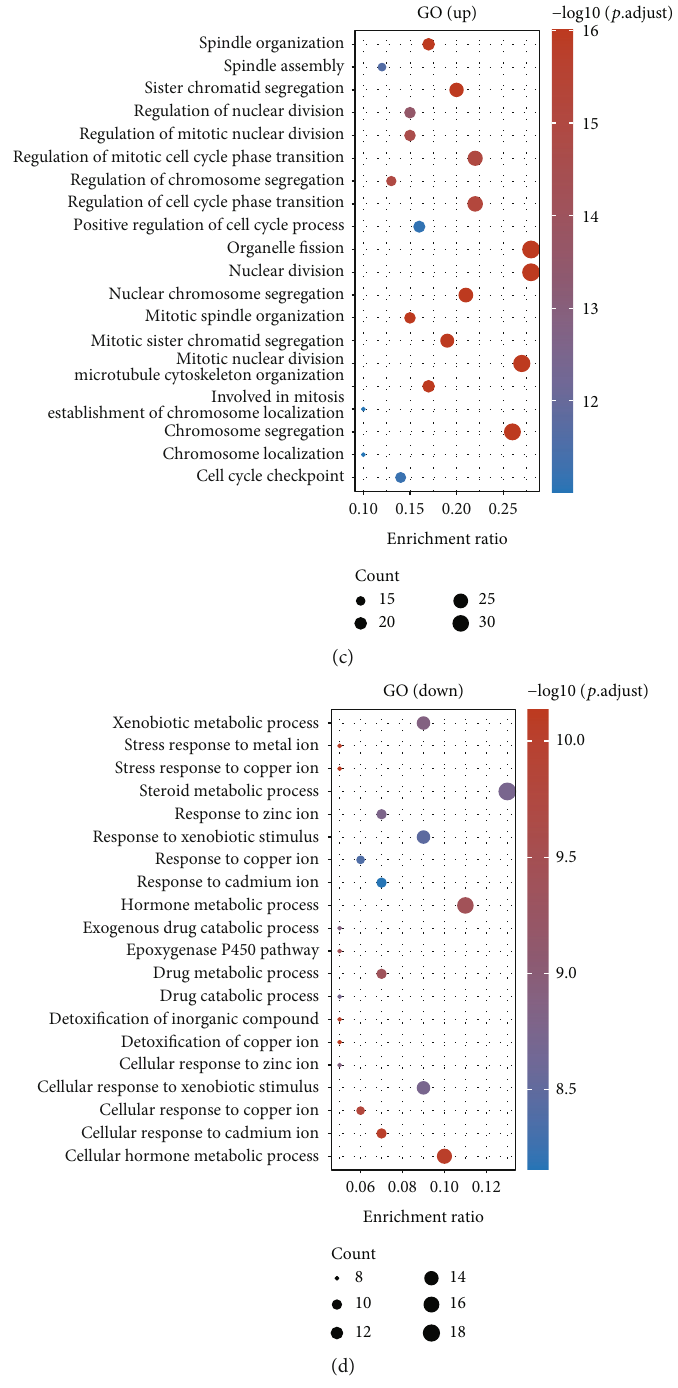
Figure 2: Functional investigation in accordance with the DEGs between normal and tumor groups in the TCGA group. (a) Barplot graph in terms of KEGG pathways. (b) Bubble graph in terms of GO enrichment using 125 increased genes. (c) Barplot graph in terms of KEGG pathways. (d) Bubble graph in terms of GO enrichment using 155 reduced